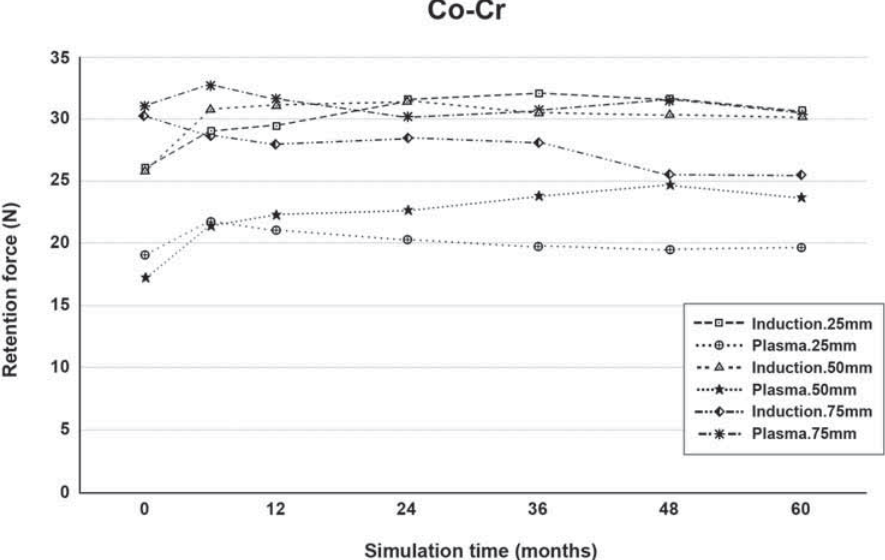
Figure 1- Retention force (N) of Co-Cr metallic frameworks for undercut (mm) x casting method (induction/centrifugation or plasma/vacuum-pressure) x time of insertion/removal simulation